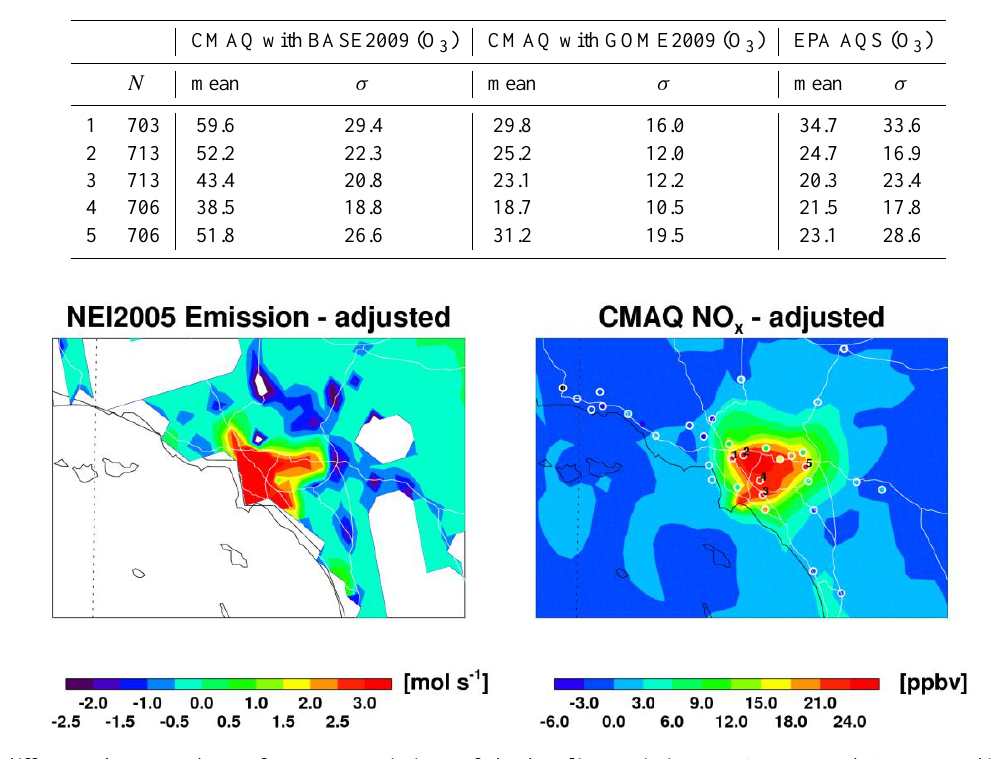
Fig. 3. The difference between the surface NO x emissions of the baseline emissions BASE2009 and GOME-2-adjusted emissions GOME2009 (left panel, the difference is estimated only when monthly NO 2 column averages are >10 15 moleculescm − 2 from GOME-2 and CMAQ over the continent); the differences between the surface NO x concentrations of the baseline CMAQ with BASE2009 and CMAQ with GOME2009 (right panel); and the differences between the baseline CMAQ with BASE2009 and EPA AQS observations (circles on the right panel) for the daytime (13:00–17:00LT) of August 2009. Among the circled stations, the five marked stations (1: Los Angeles, 2: South Pasadena, 3: Anaheim, 4: La Habra, and 5: Riverside) include large discrepancies in >daytime 20ppbv NO x (baseline CMAQ simulations – EPA AQS